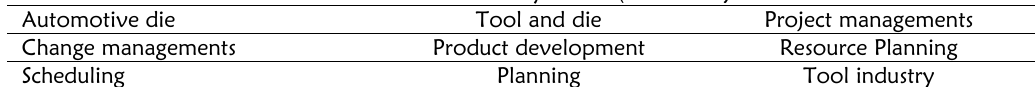
Table 8: Searched key words (additional)